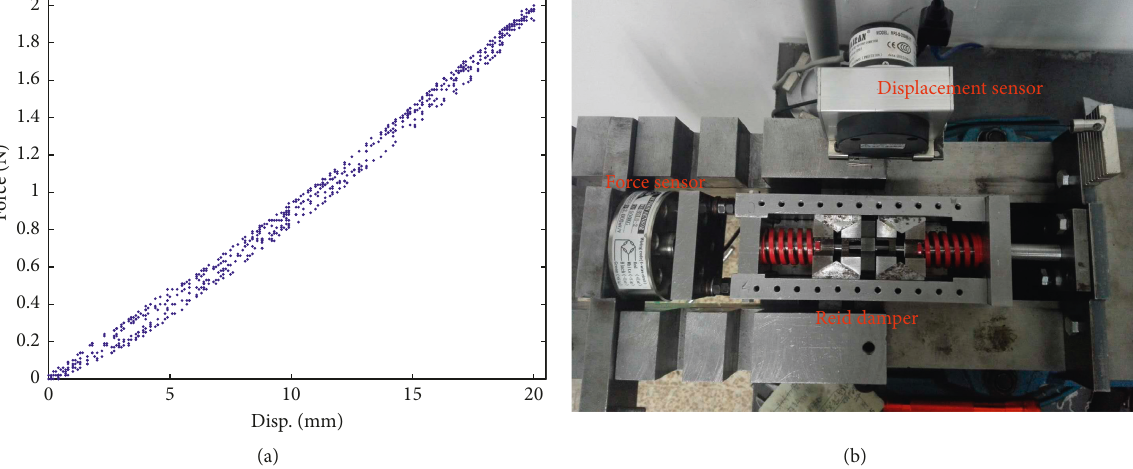
Figure 6: Performance test of the spring and the damper: (a) performance test of the spring; (b) loading scheme of the damper performance